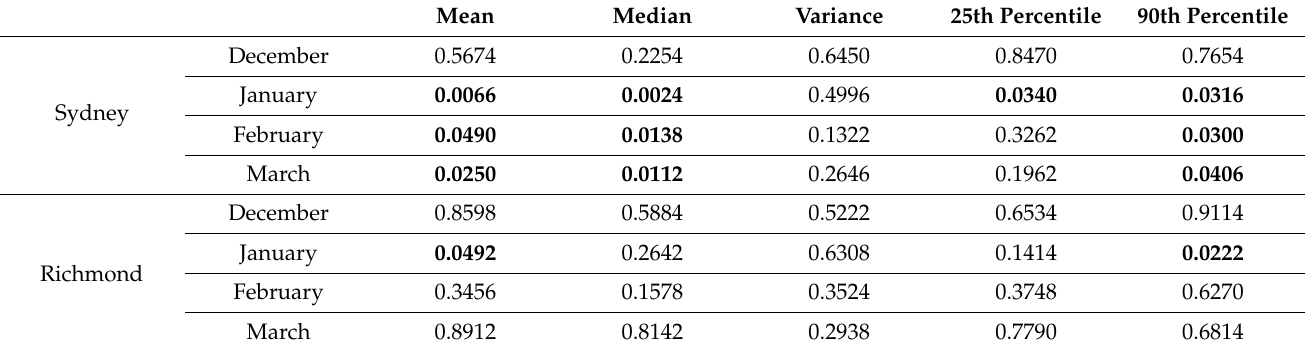
Table 1. p -values of difference in mean, median, variance, 25th percentile, and 95th percentile for each summer month. p -values < 0.05 for the mean, median, and variance are in bold, as are p -values for the changes in the 25th and 90th percentiles. Tests were conducted using 5000 resamples. Mean Median Variance 25th Percentile 90th Percentile